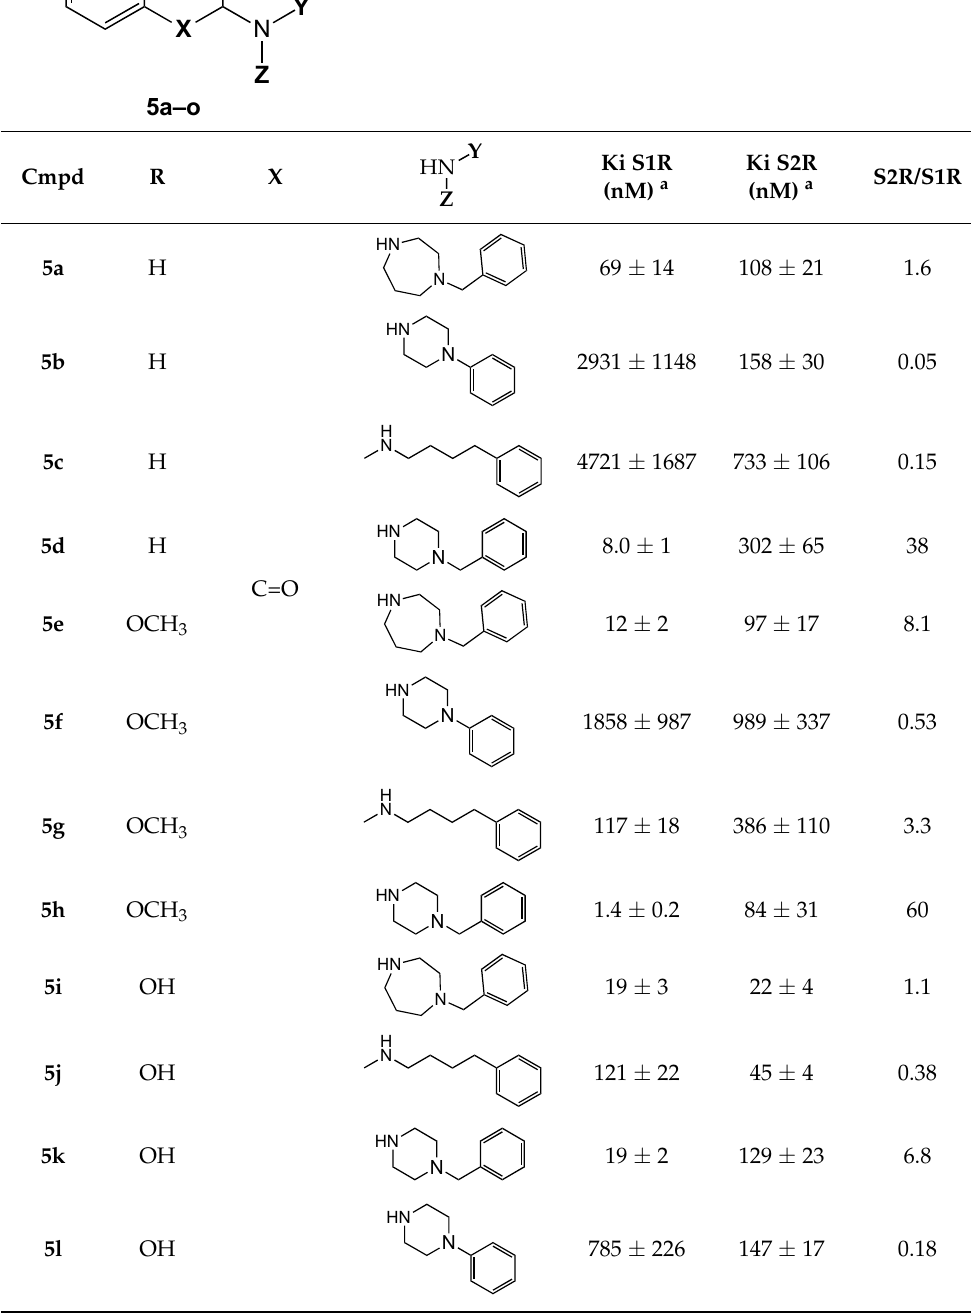
Table 2. Binding affinities towards S1R and S2R, for compounds 5a – o .